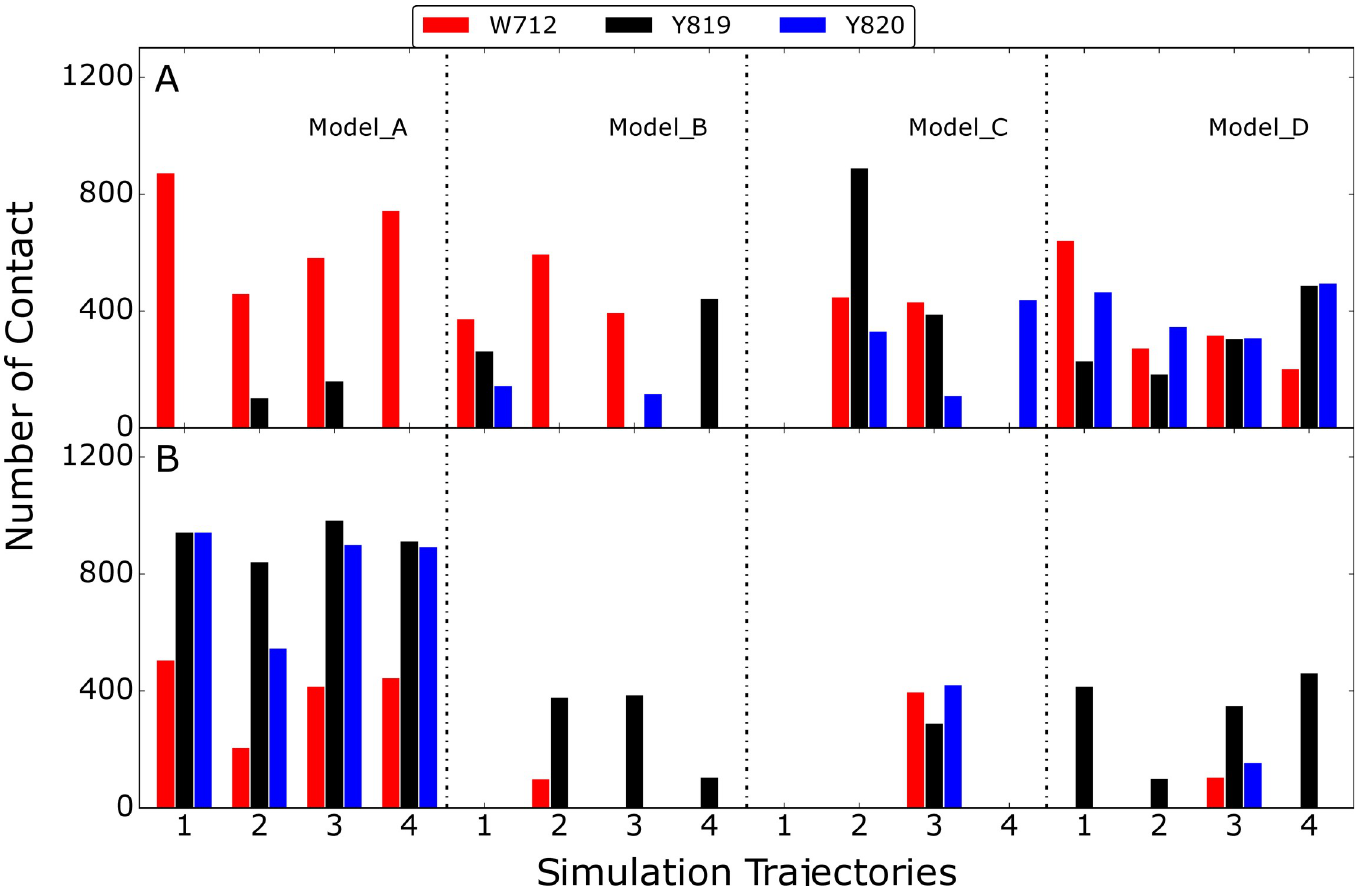
Fig 11. Number contact between W712, Y819 and Y820 on the CBM and A) protein portion of Fc or B) glycan portion of Fc. Results are shown for the four models with the four individual bar graphs under each model corresponding to four independent MD simulations. Number of contacts was calculated by counting frames with heavy atom that are within 4 Å from those selected amino acids based on snapshots extracted every 50 ns from the simulations.